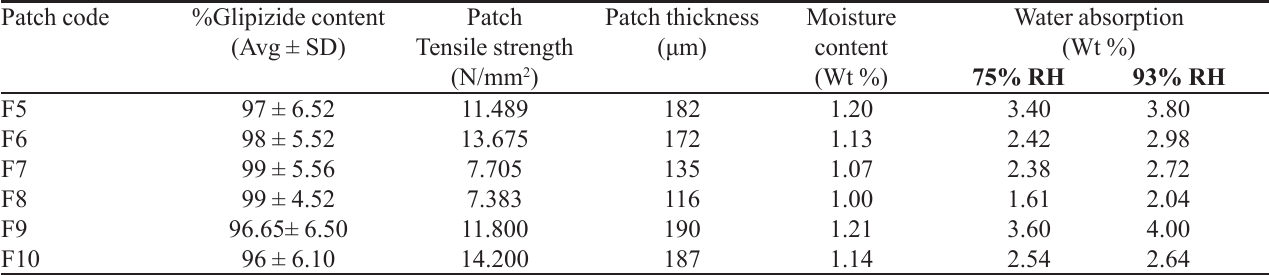
TABLE II - Patch characteristics Patch